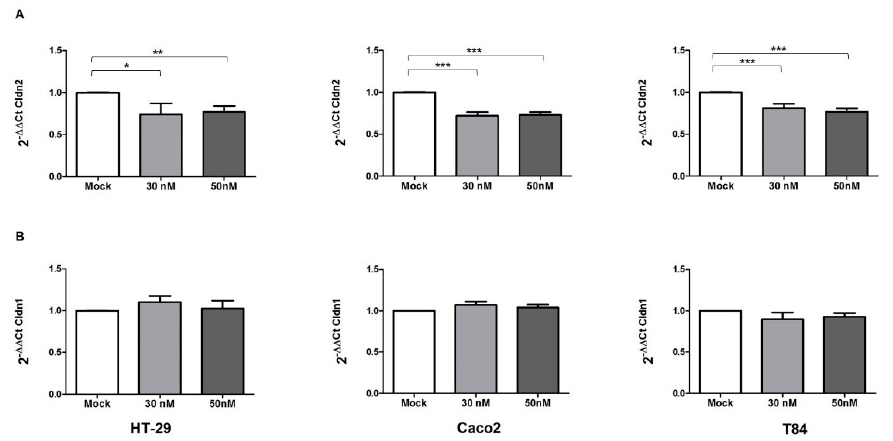
Figure 4. miR-195-5p regulates Cldn2 mRNA expression. (A) Cldn2 mRNA expression was analyzed by Real-Time PCR after transfection with miR-195-5p mimic in HT-29, Caco2, and T84 human cell lines. The increased intracellular amount of miR-195-5p (at 30 nM and 50 nM concentrations) led to a significant decrease of Cldn2 in all cell lines. (B) Cldn1 mRNA expression was analyzed by Real-Time PCR after transfection with miR-195-5p mimic in HT-29, Caco2, and T84 human cell lines. The levels of Cldn1 remained similar to mock-control in all cell lines. Expression data were normalized to the housekeeping gene Gapdh. Data are representative of four independent experiments (mean ± SEM). * p < 0.01, ** p < 0.001, *** p < 0.0001.